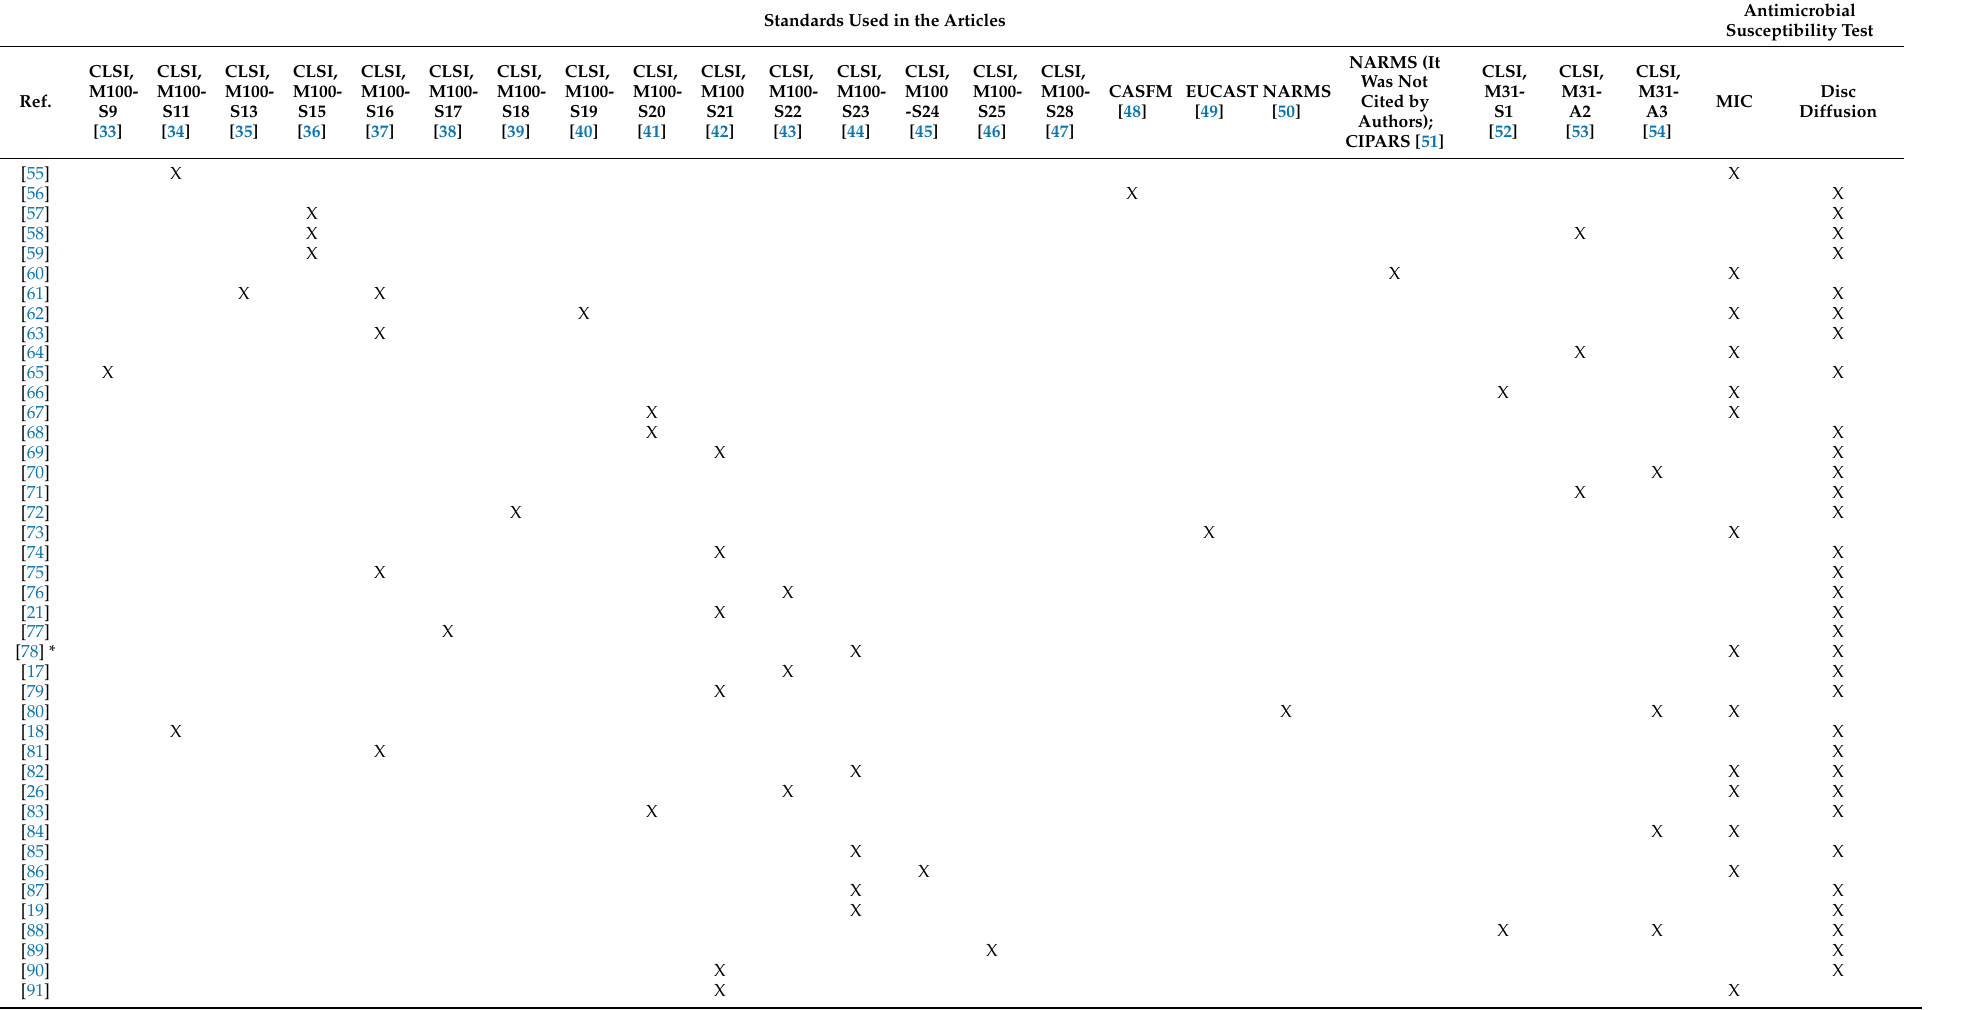
Table 1. Standards used to define the interpretation criteria for antimicrobial susceptibility tests in selected